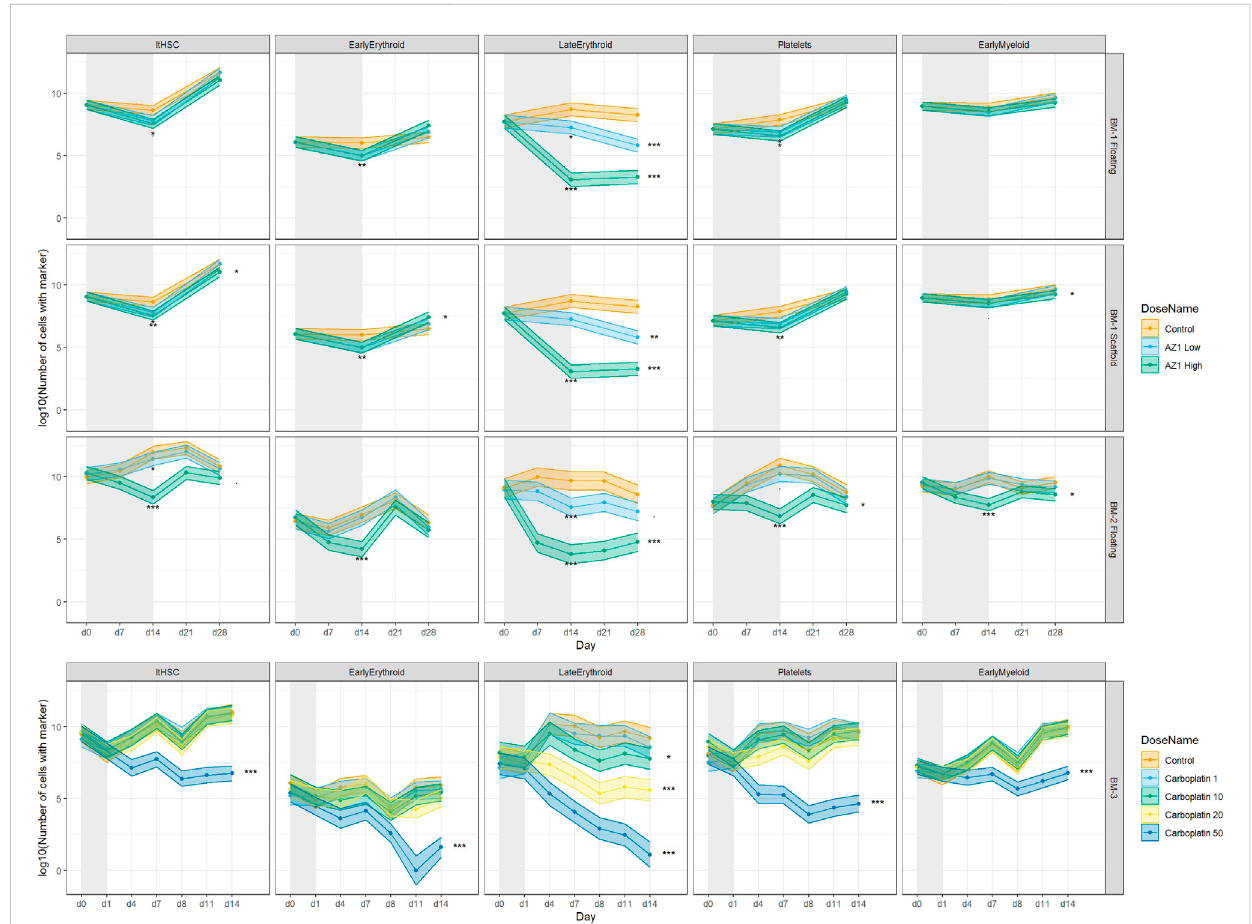
FIGURE 7 Treatment-induced lineage-speci fi ctoxicity. The effect oftreatmentwith AZ1 or carboplatin on different haematopoieticlineages over time in BM- 1,BM-2orBM-3studies.Theshadedregionsrepresentthedosingperiodineachcase.Starsrepresenttheresultsofthesigni fi cancetests,atboththeend ofthedosingperiodandtheendoftherecoveryperiodforeachdrug(notethatcarboplatinshowednosigni fi canteffectsattheendofthedosingperiod), Signi fi cance values are ( < 0.1), * ( p < 0.05), ** ( p < 0.01), *** ( p < 0.001).